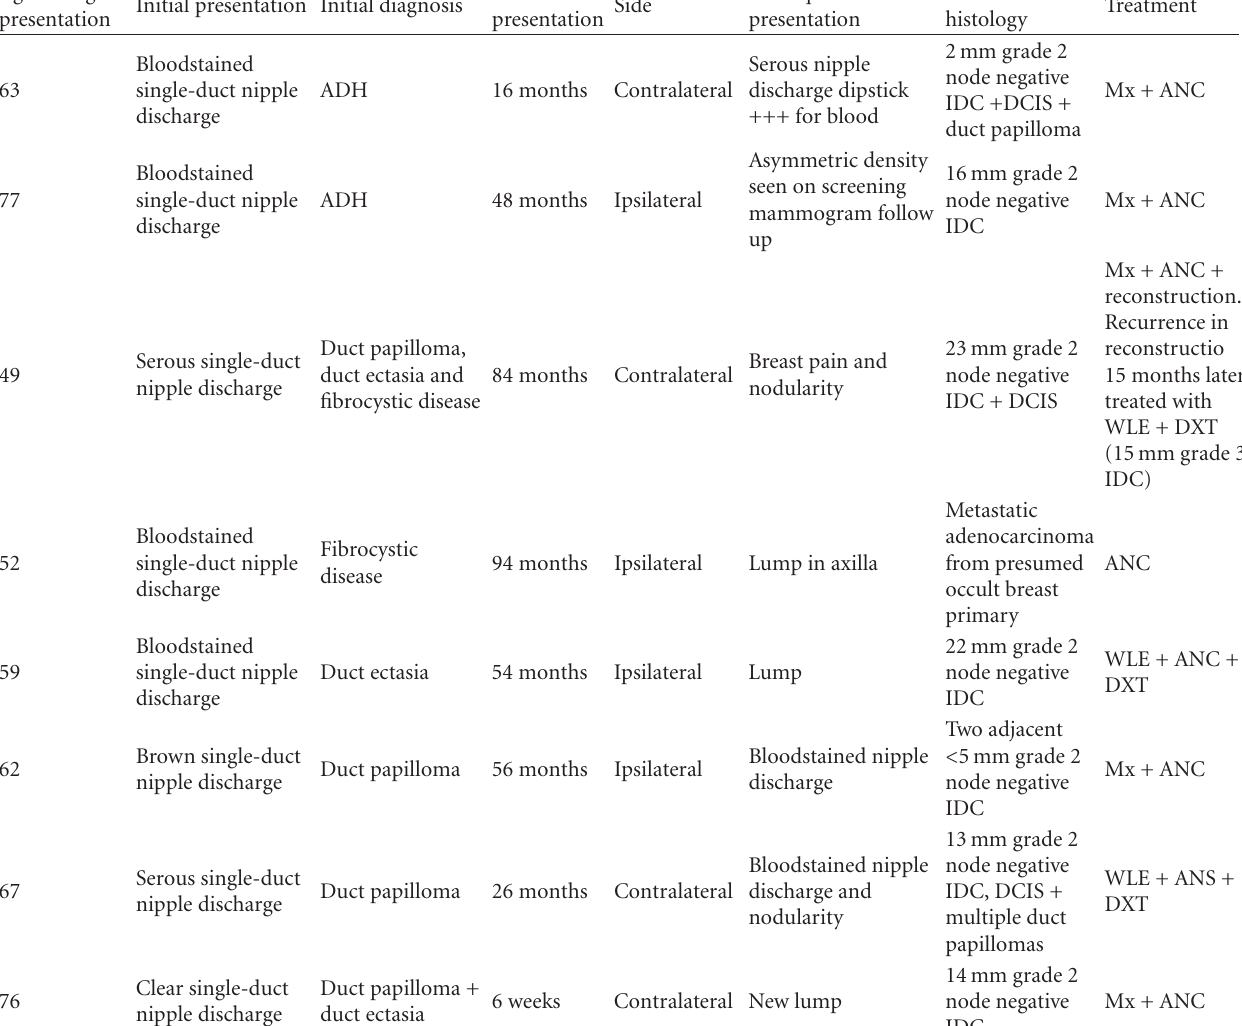
Table 4: Patients with benign diagnoses at duct excision, who subsequently represented with breast cancer. Age at